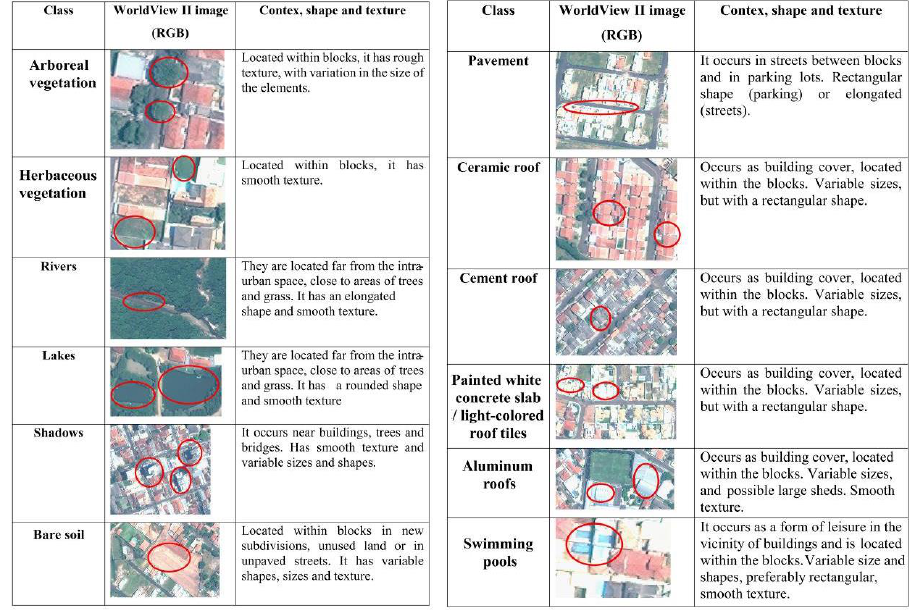
Figure 3. Interpretation key.